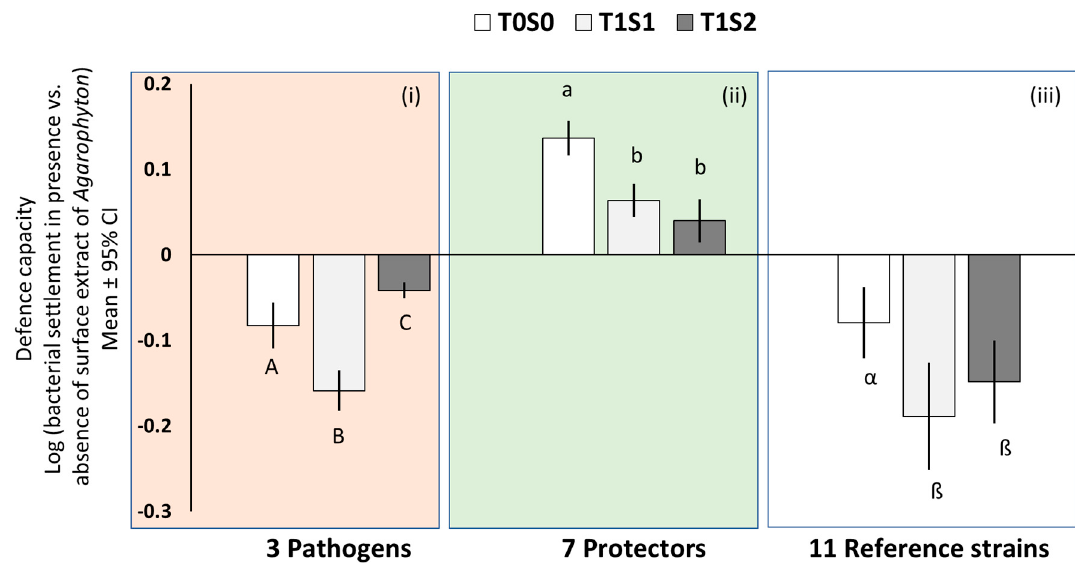
Figure 1. Mean antisettlement activity of A . vermiculophyllum surface-associated metabolites originating from field-collected samples (T0S0), samples generated after 5 months of low salinity treatment (T1S1), and samples generated after 5 months of medium salinity treatment (T1S2) against 3 pathogenic ( i ; 1-way ANOVA, Tukey’s honestly significant di ff erence test (HSD), p < 0.0001), 7 protective ( ii ; 1-way ANOVA, Tukey’s HSD, p < 0.0001), and 11 reference strains ( iii ; 1-way ANOVA, Tukey’s HSD, p < 0.0001). Capital Latin letters indicate extracts that significantly di ff ered in defence activity against pathogens, whereas small Latin letters indicate extracts that significantly di ff ered in probiotic activity against protectors. Greek letters indicate extracts with significantly di ff erent activity against tested reference strains. Error bars ± CI ( n = 5). Note: Defence capacity (against pathogen and protectors only) at T0S0 have been published in [9] and serve here as reference time points to compare the capacity of the alga at T1S1 with T0S0 and T1S2 with